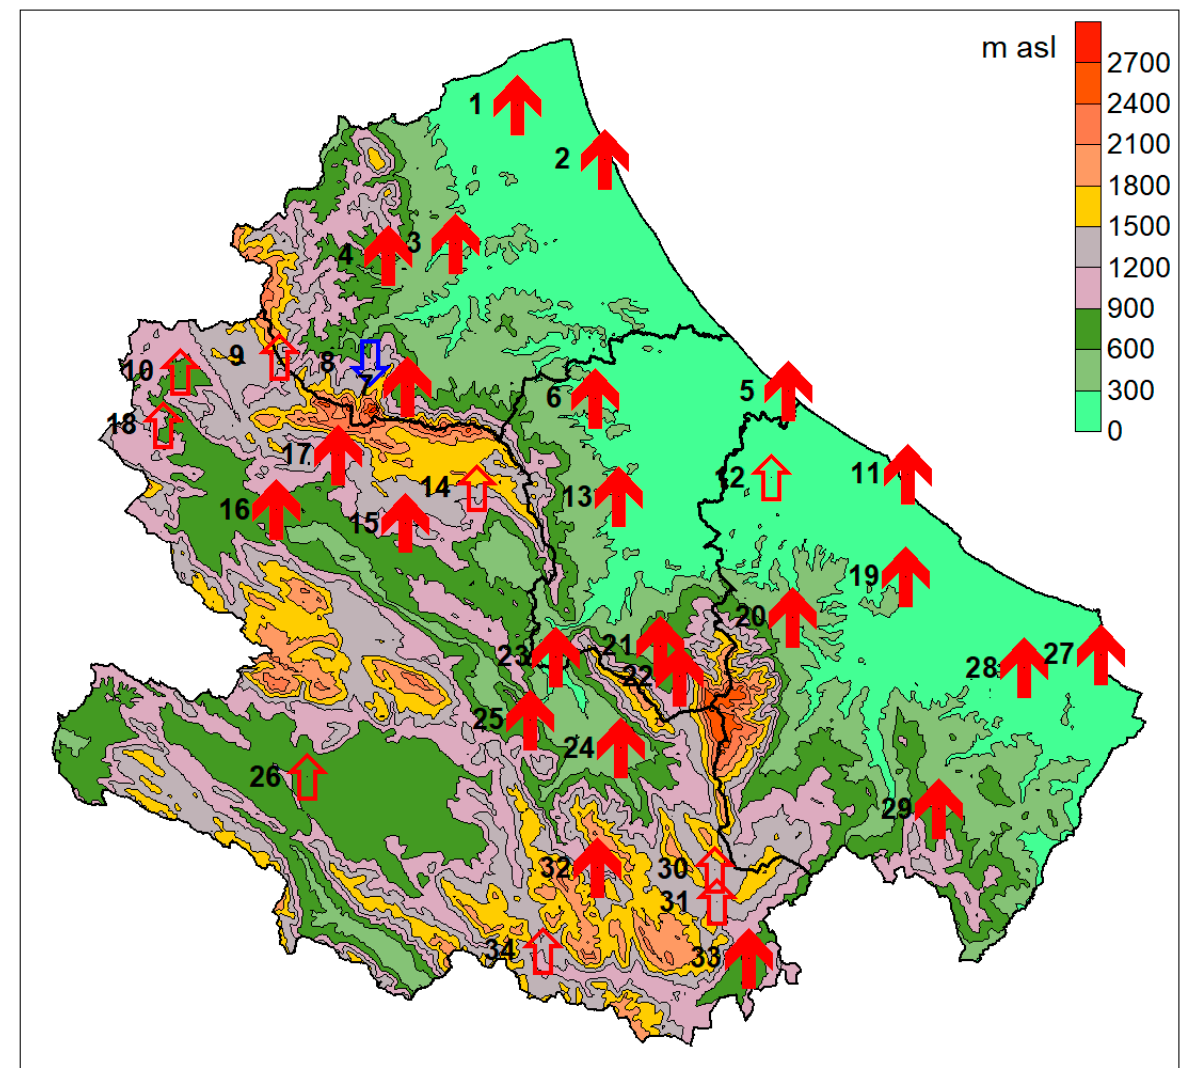
Figure 4. Map of the Abruzzo Region, indicating the increasing or decreasing trends of the number of days with maximum temperatures over 30 °C. The downward arrow indicates a decreasing trend, while the upward arrows indicate increasing trends. Full arrows indicate significant trends with p < 0.05, while empty arrows indicate no significant trends. The number next to the arrow indicates the numeric code of the meteorological station. The red arrows represent a warming trend, while the blue arrows represent a cooling trend. The altitude classes are given on the upper right.